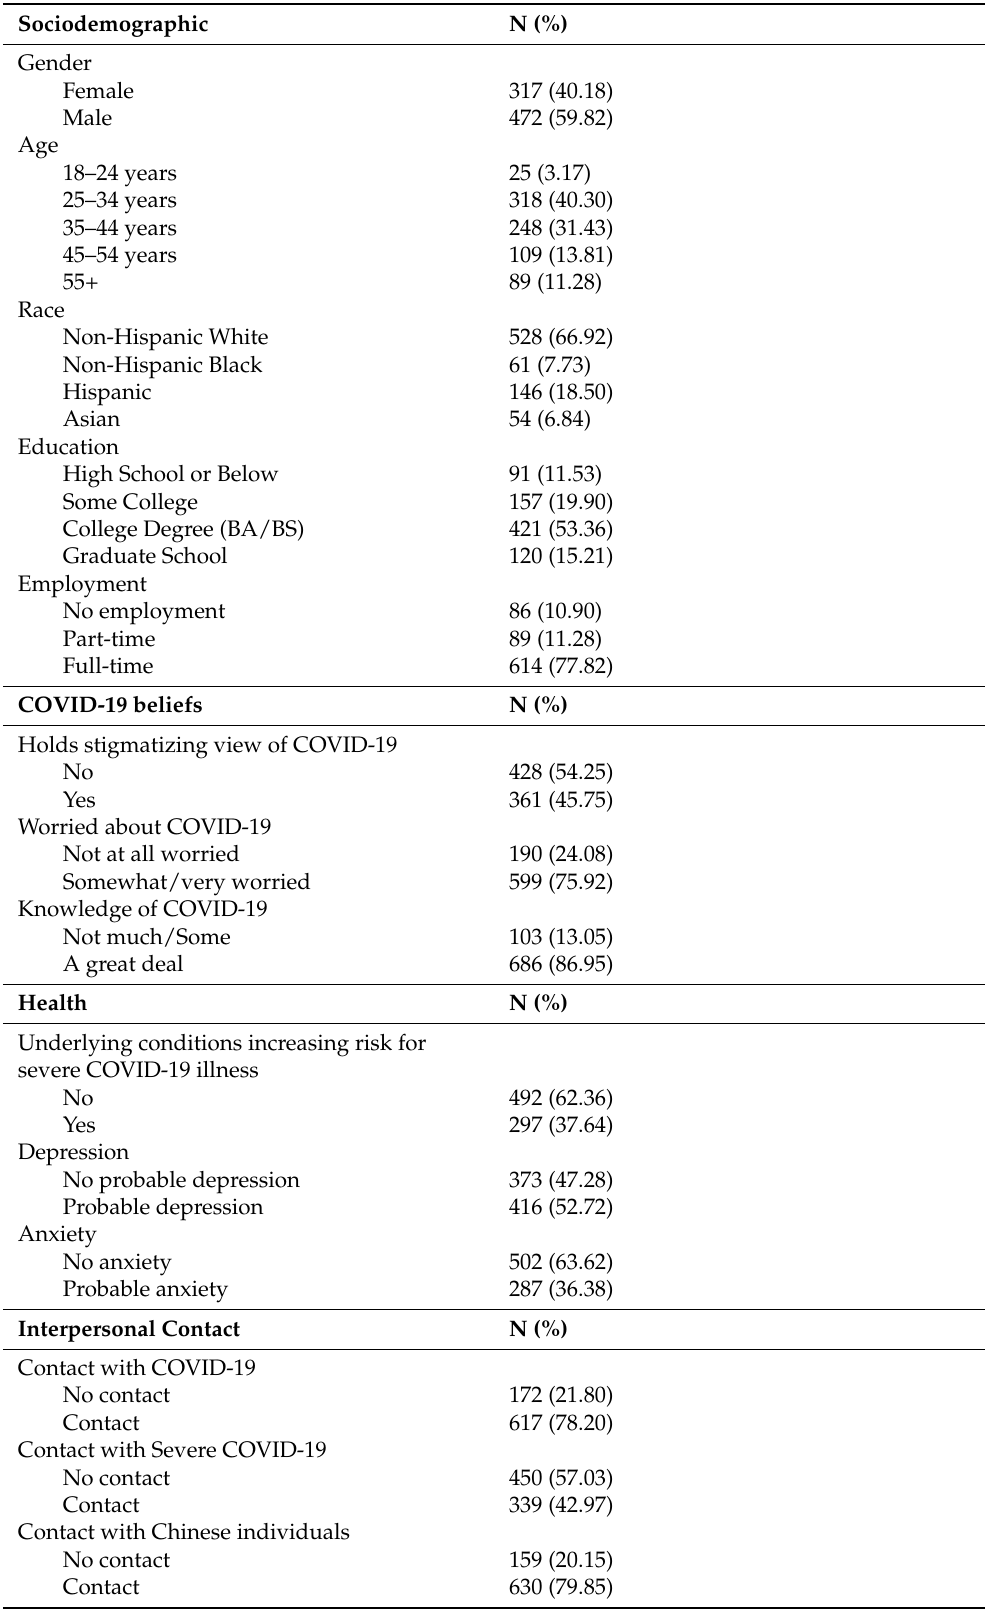
Table 1. Descriptive statistics of the non-representative national sample, N =